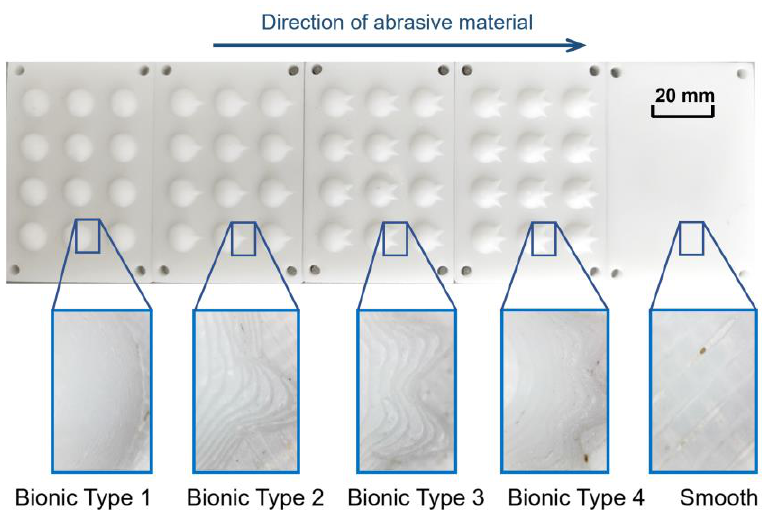
Figure 6. Wear surfaces in macroscopic scale of five types of abrasive wear experimental samples (the direction of abrasive material is from left to right).